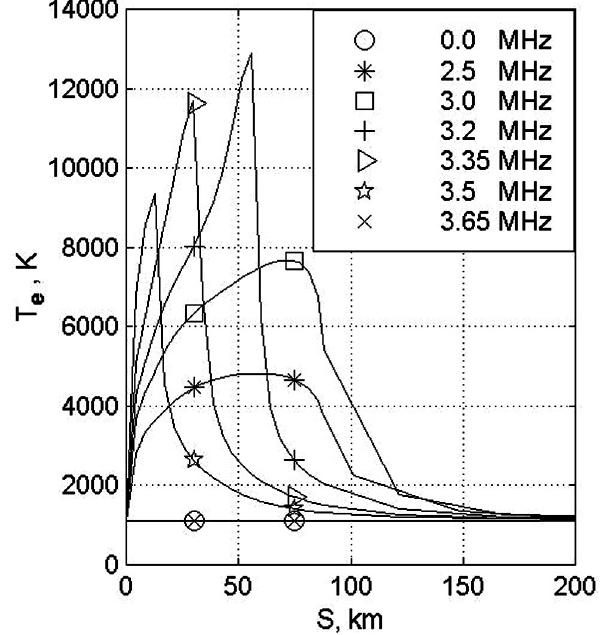
Fig. 4. Profiles of the electron concentration versus distance from the Earth along the geomagnetic field line situated in the illuminated region at S = 55 . 89km. The results are given for the same cases as in Fig. 3.